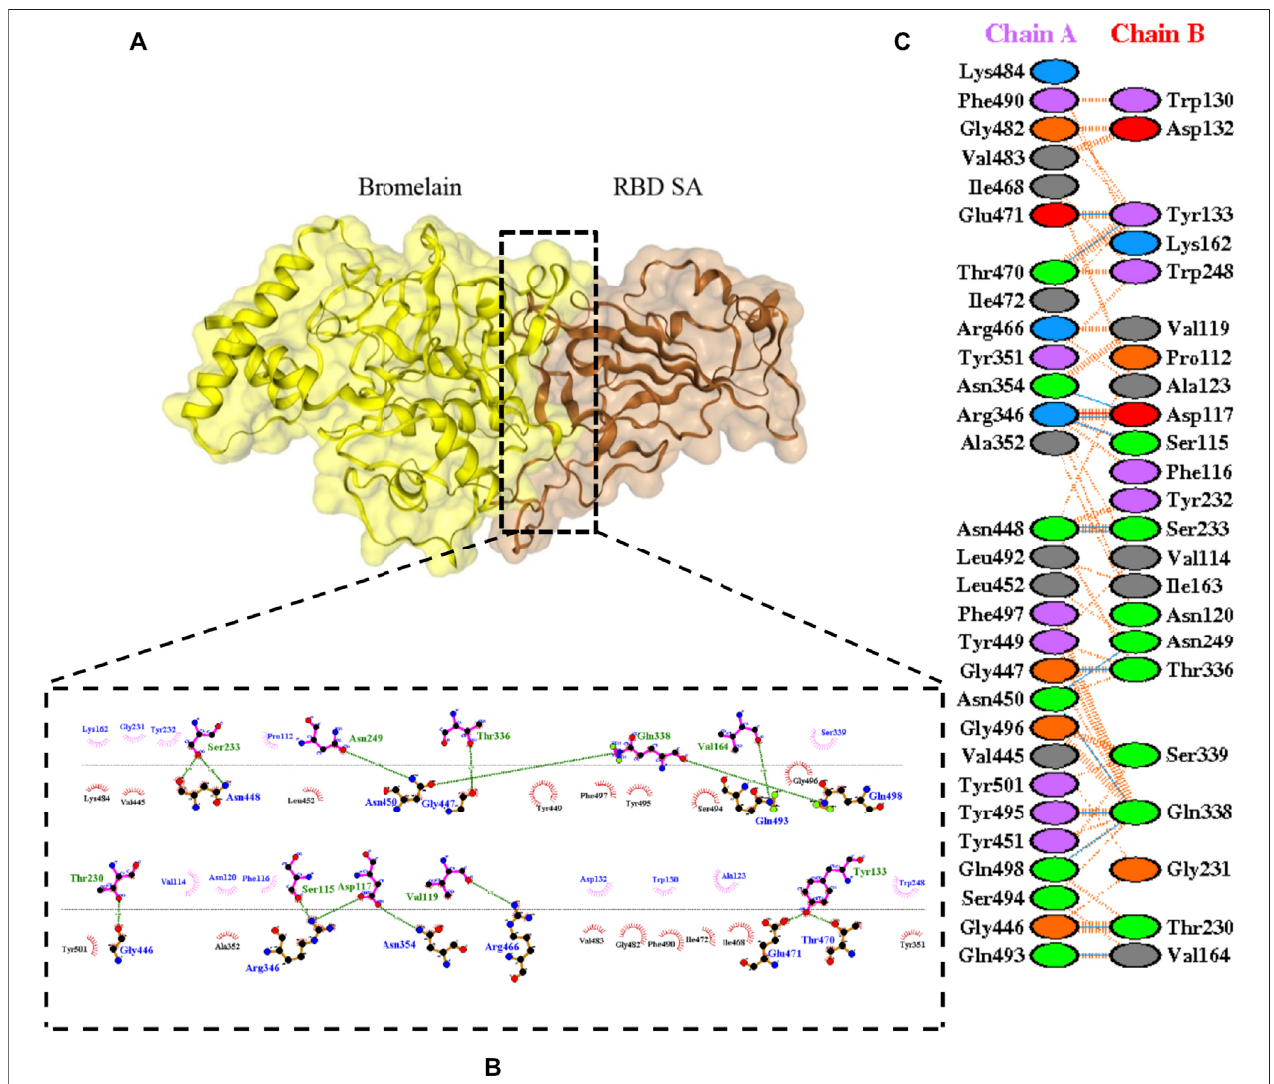
FIGURE 6 | Docking representation of the SA variant and bromelain complex. (A) the binding interface of the complex, (B) the binding interaction between the amino acids, and (C) interaction representation including hydrogen, salt bridges, and nonbonded interactions. Chain A is RBD SA and chain B is bromelain.